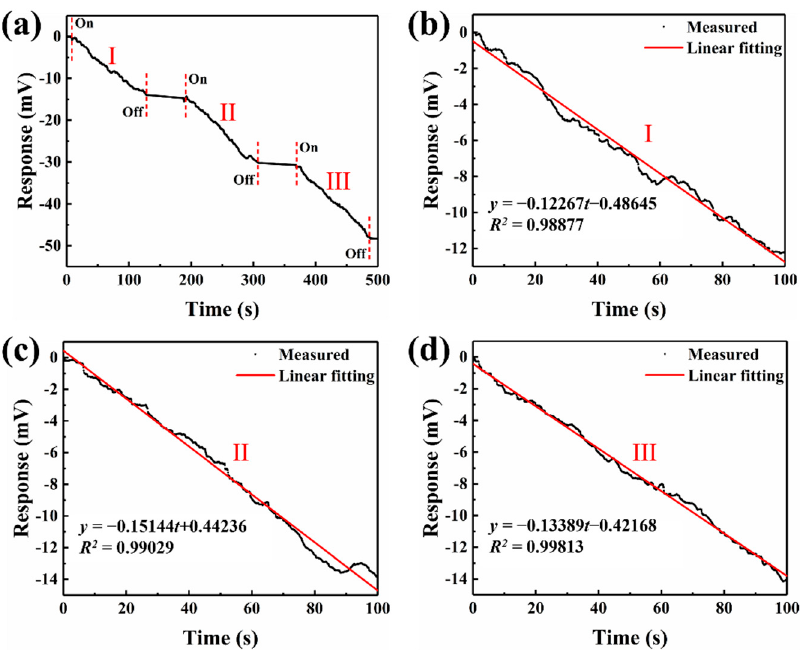
Figure 16. PM 1 – 2.5 stage collecting results in indoor condition and its linear fitting: ( a ) Partial figure of repeated sampling results; ( b ) Results of the first test; ( c ) Results of the second test; ( d ) Results of the third test.